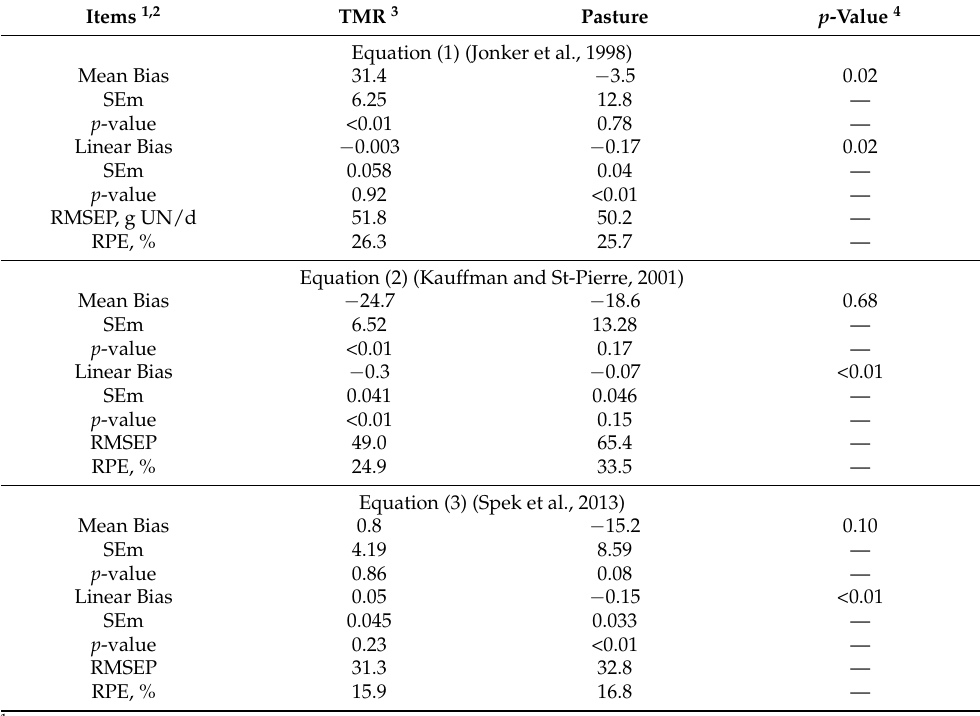
Table 2. Performance of established urinary nitrogen (UN, g/d) prediction equations. Biases were determined by regressing the Observed minus Predicted values by the mean centered predicted estimates, using the experiment as a random effect and weighting for UN standard error of the mean